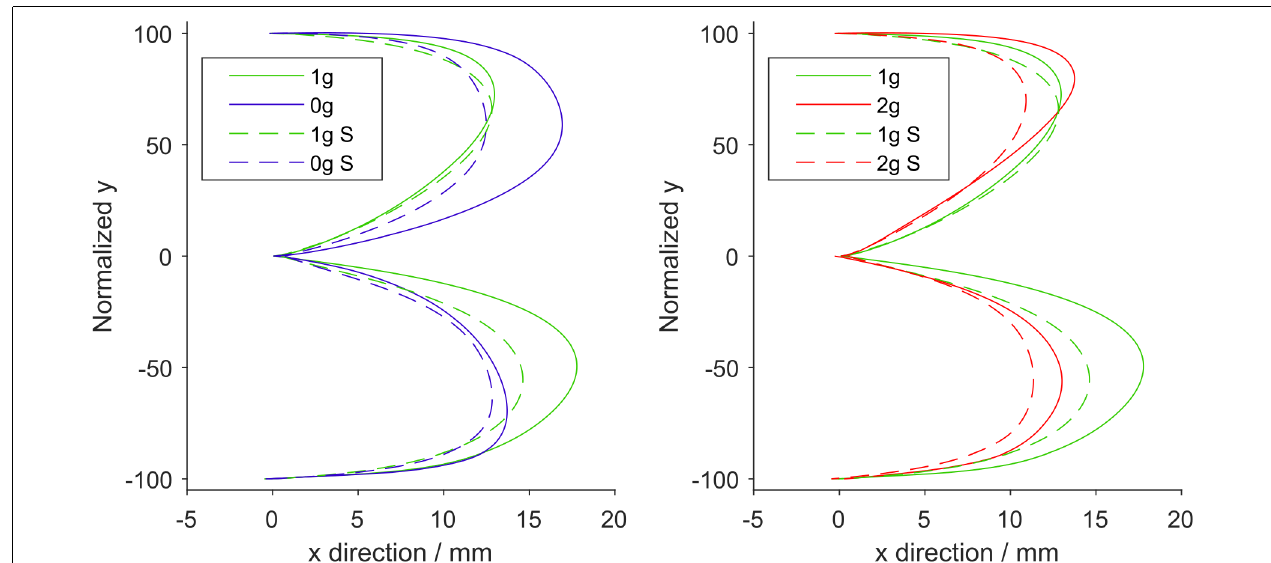
FIGURE 6 | Mean trajectories normalized for target distance for different gravitational and simulation conditions. Left: normogravity and microgravity conditions, Right: normogravity and hypergravity conditions. All trajectories start at the coordinate (0, 0) and end at either (0, 100) for upward movements or (0, − 100) for downward movements. Solid lines represent the conditions during flight (1g, 0g, 2g) whereas dashed lines represent the simulated conditions (1g S, 0g S, 2g S). Green represents normogravity, blue represents microgravity and red represents hypergravity conditions.